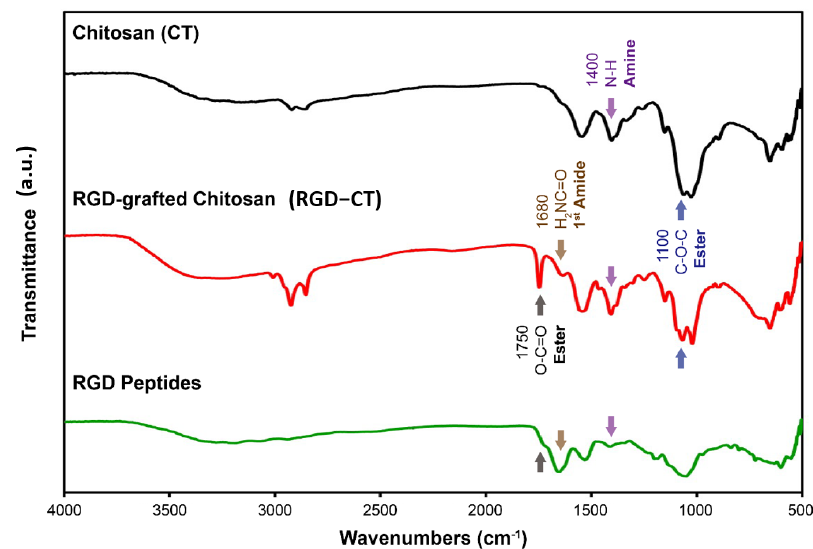
Figure 2. FTIR analysis of the RGD peptide, RGD−Chitosan conjugate, and fully deacetylated chitosan. The stretching vibration absorption band of the ester group (OC=O) is at 1750 cm −1 , while that for the primary amine bond (H2NC=O) is at 1680 cm −1 , and ester bond is at 1100 cm −1 .